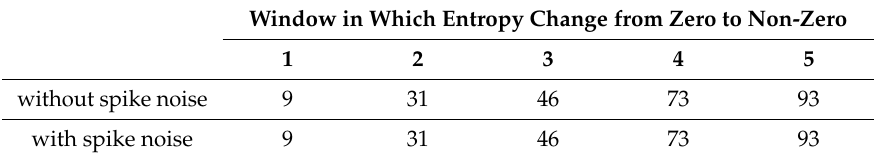
Table 5. The windows of entropy values change from zero to non-zero.